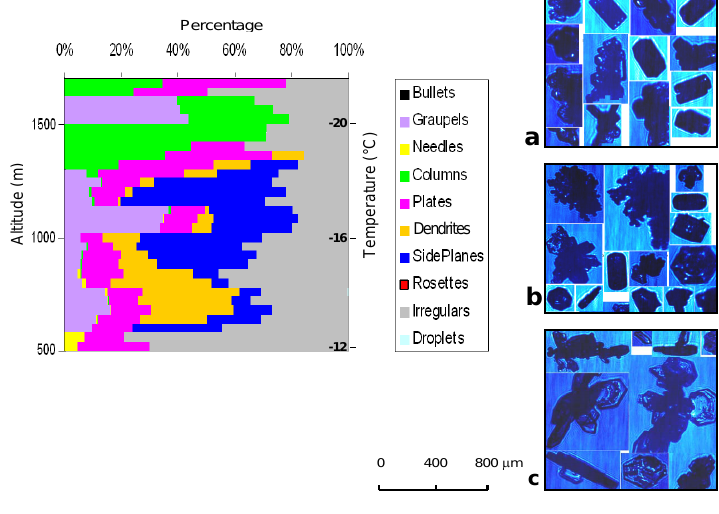
Fig. 5. Vertical profile of the ice particle shape classification (represented for number and for D> 100 µ m) with examples of ice particles images sampled by the CPI probe at three flight levels: (a) 1700m/ − 21 ◦ C, (b) 1000m/ − 16 ◦ C, (c) 500m/ − 12 ◦